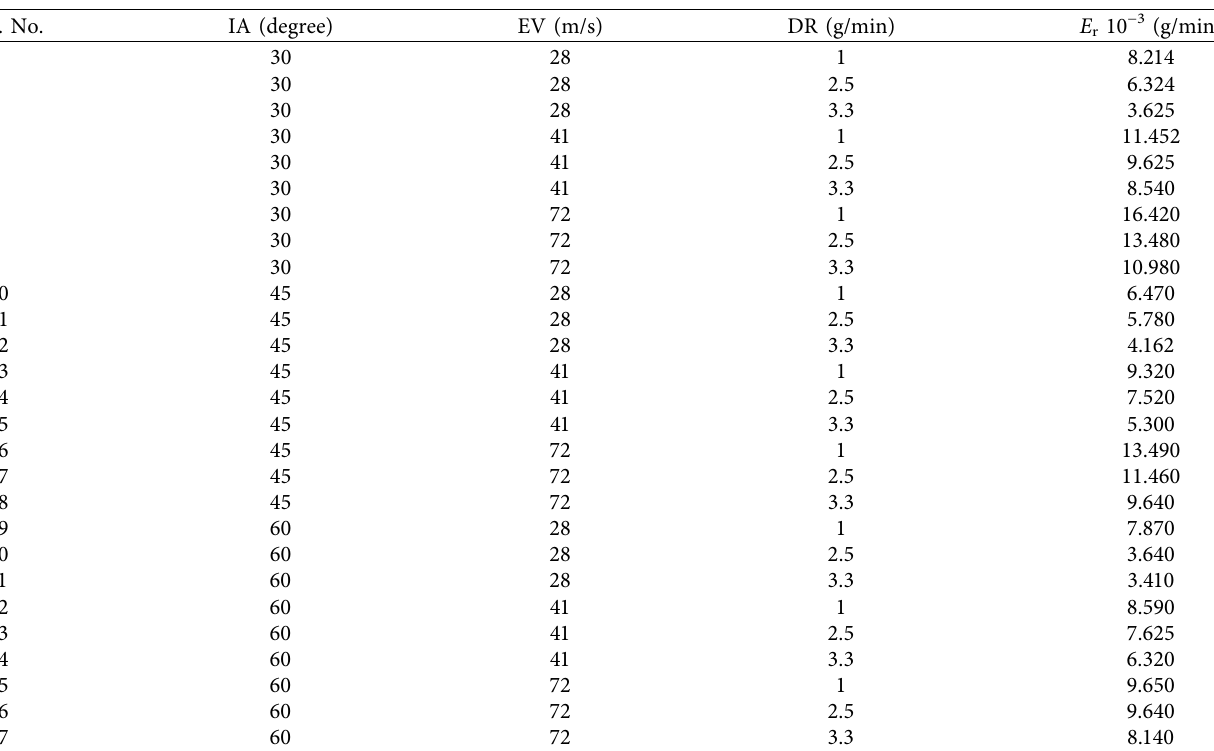
Table 6: Experimental observation for air jet erosion